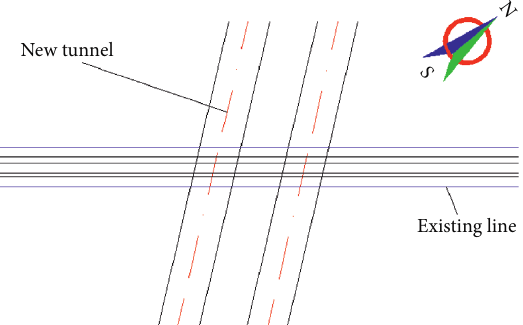
Figure 1: The horizontal relationship between the shield tunnel and existing track line.